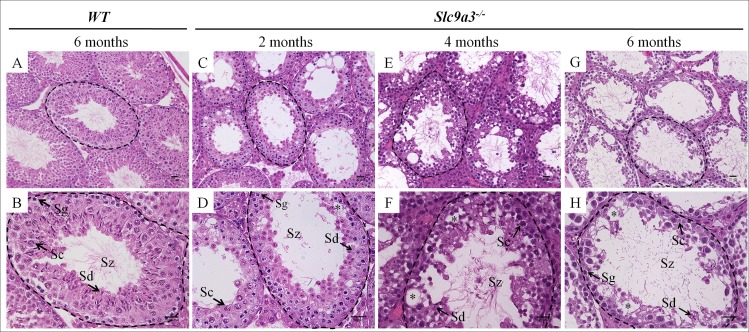
Loss of SLC9A3 induces testicular atrophy.Testicular histology was assessed by H&E staining of testis sections of 6-month-old WT mice (A, B) and Slc9a3-/- mice of different ages (C–H). (A, B) Representative images showing the intact architecture of the seminiferous tubules and interstitial tissue in the testes of WT mice. (C–H) H&E staining of the testes of 2- (C, D), 4- (E, F), and 6–month-old (G, H) Slc9a3-deficient mice. Vacuolation of seminiferous epithelia was observed in the seminiferous tubules of Slc9a3-/- mice (asterisk). The dashed line marks the intact lumen of the seminiferous tubules. The lower panel is the higher magnified images of the area indicated using a black dashed line in the upper panel; scale bar = 20 μm. Abbreviations: Sg, spermatogonia; Sc, spermatocyte; Sd, spermatid; Sz, spermatozoa.